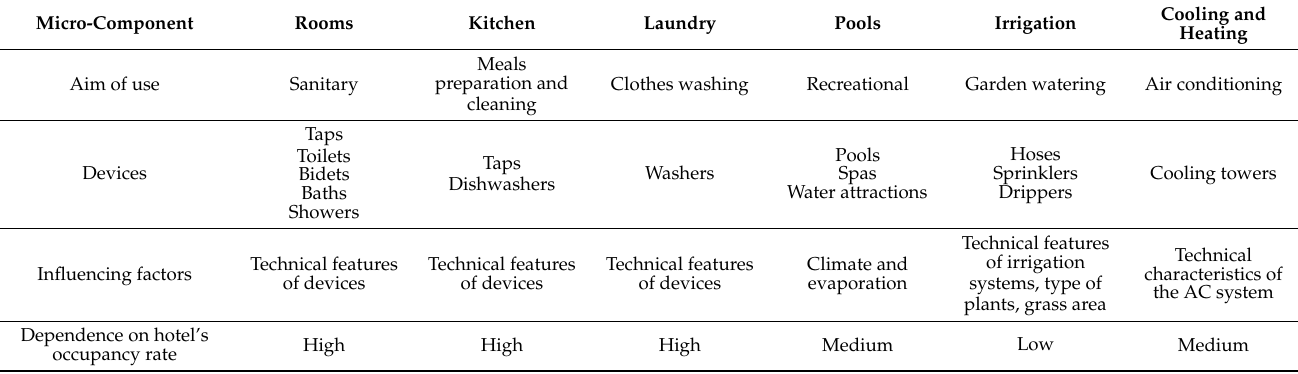
Table 1. Summary of characteristics of water consumption for each